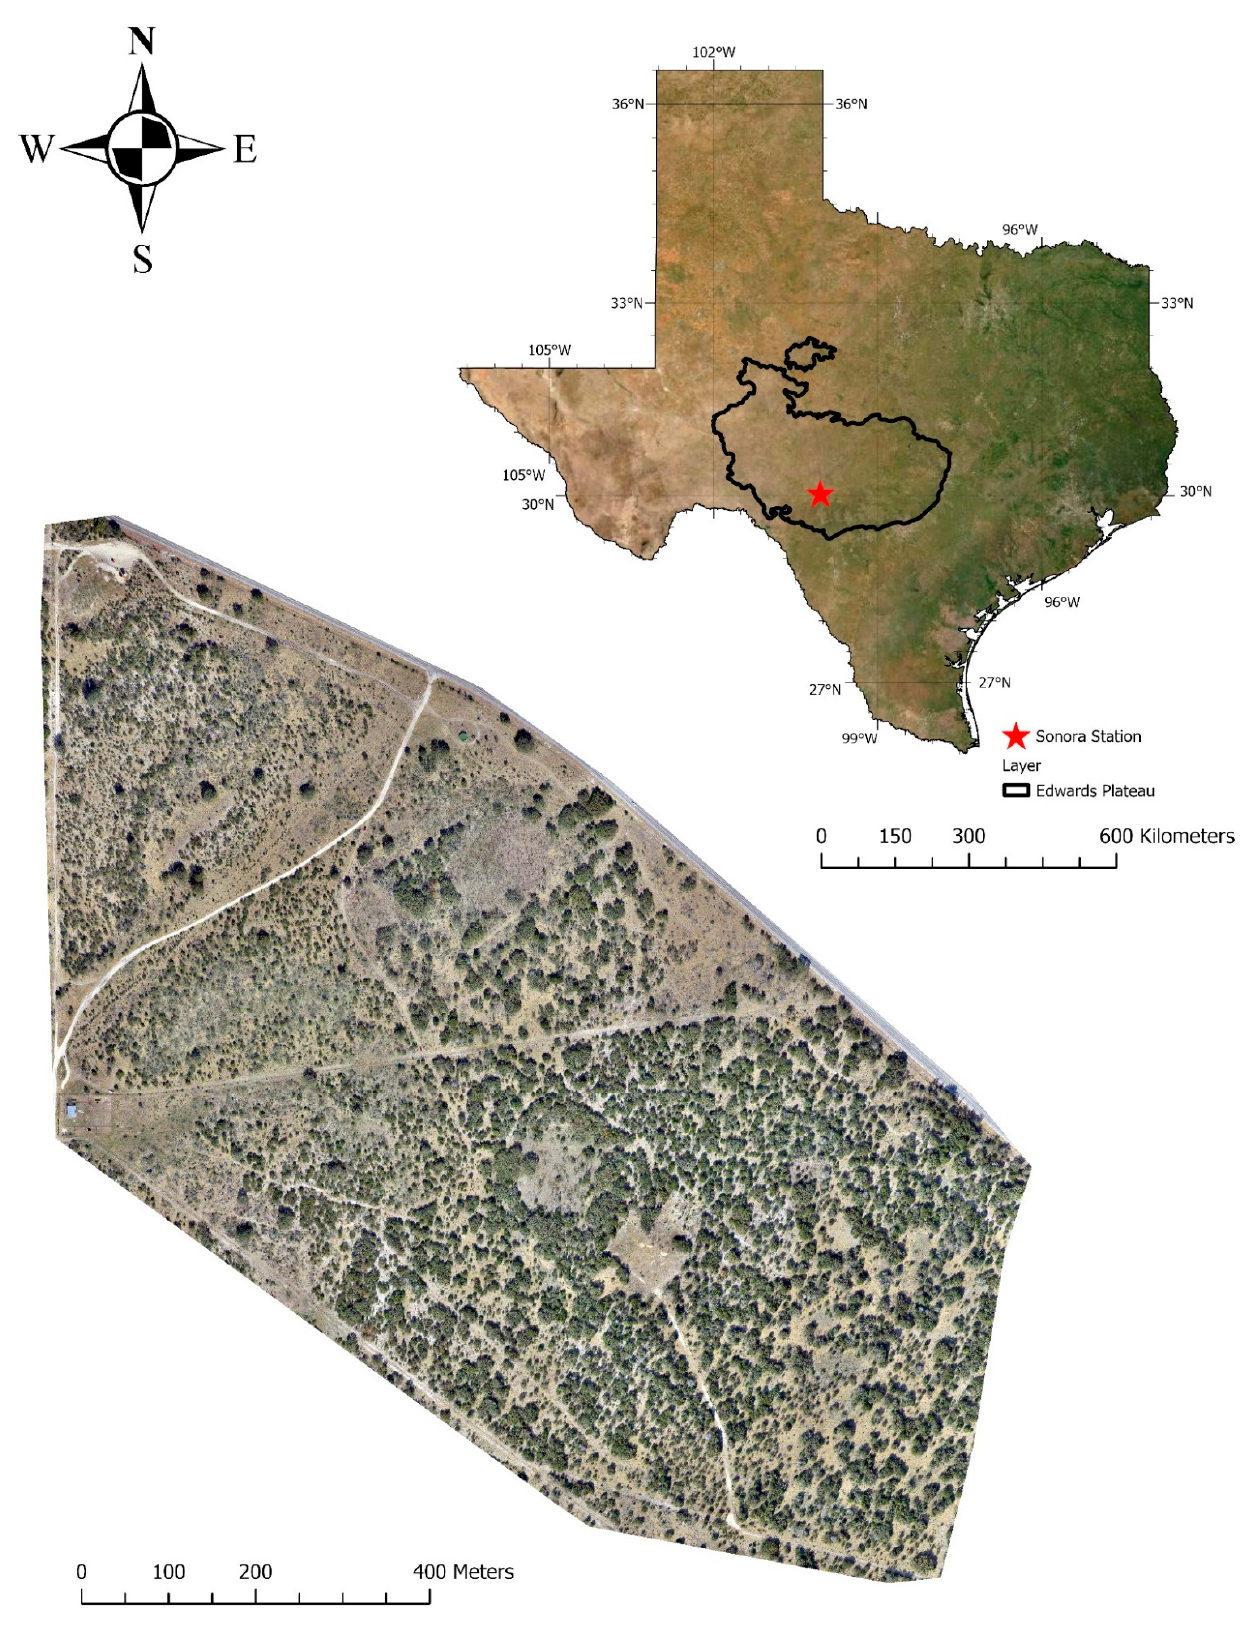
Figure 2. Location of the study site. It covers a small portion of the southwest region of the Edwards Plateau ecoregion in the state of Texas, USA.